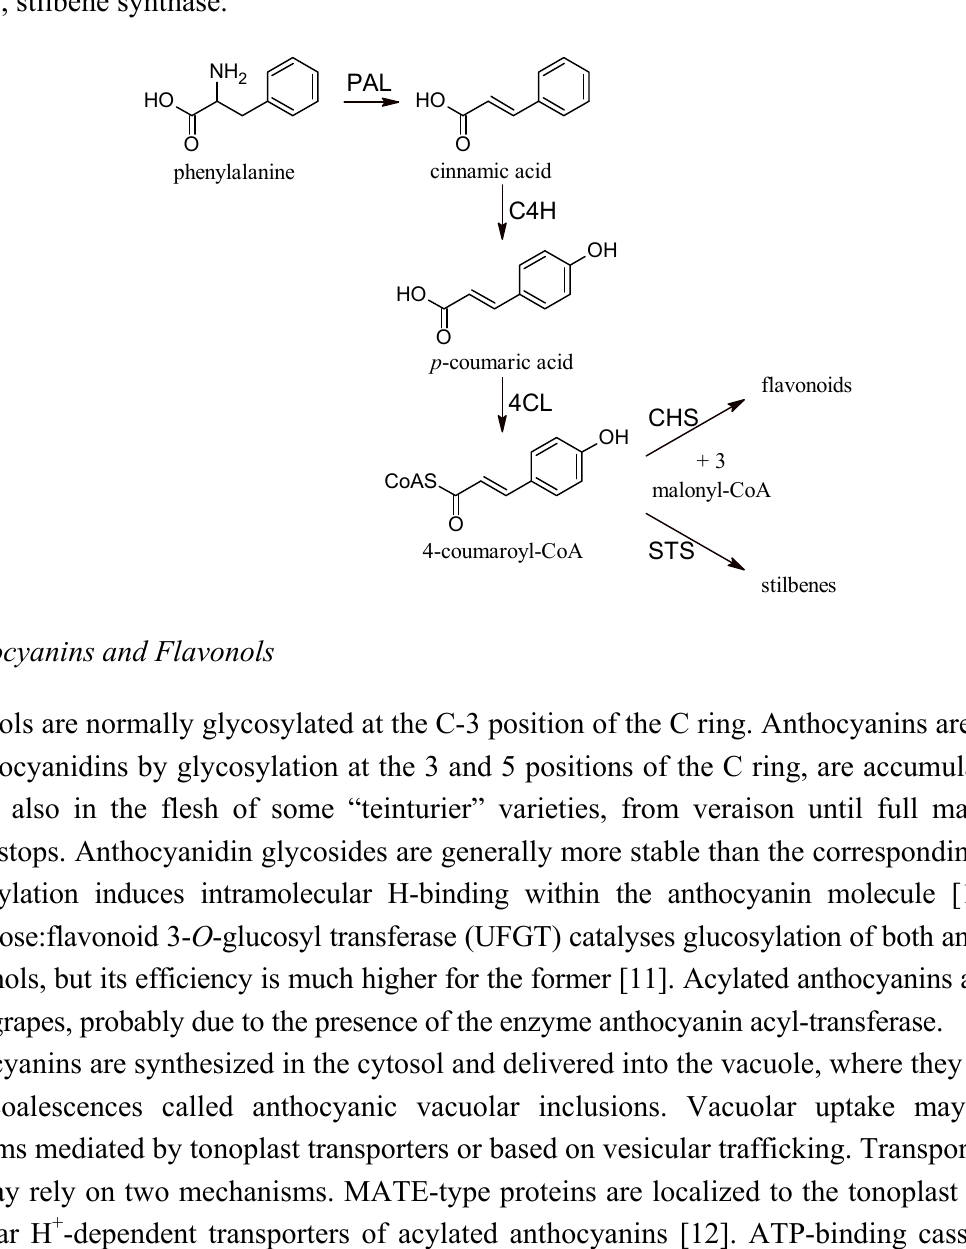
Figure 1. General phenylpropanoid pathway. PAL, phenylalanine ammonia lyase; C4H, cinnamate-4-hydroxylase; 4CL, 4-coumaroyl:CoA-ligase; CHS, chalcone